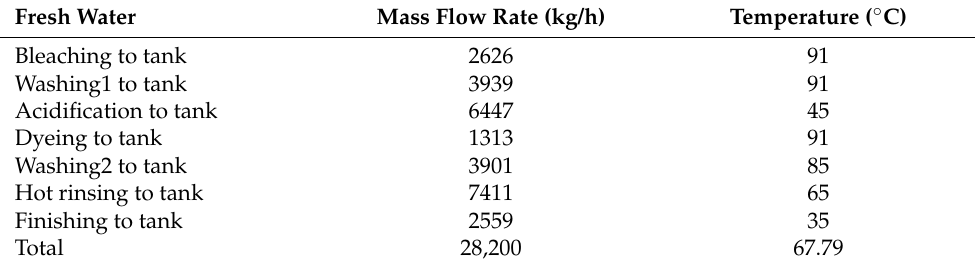
Table 5. Flow rate and temperature of heat-recovered freshwater (Case 2).